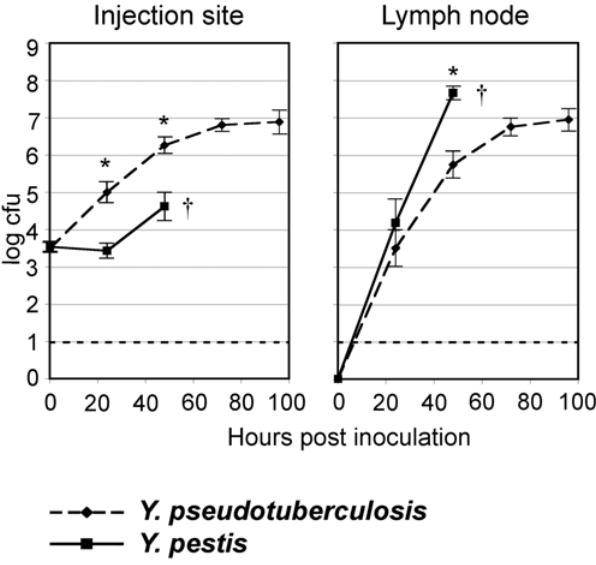
Figure 1. Bacterial loads at injection site and in draining lymph node. Data are means of log 10 of cfu numbers recovered from 77 mice infected over six independent experiments. Bars=Standard Errors. Stars indicate that the data are significantly different between the two Yersinia species (p # 0.0001). The dashed line shows the detection limit (10 cfu). The cross symbol indicates that most Y. pestis -infected mice died between days 2 and 3.